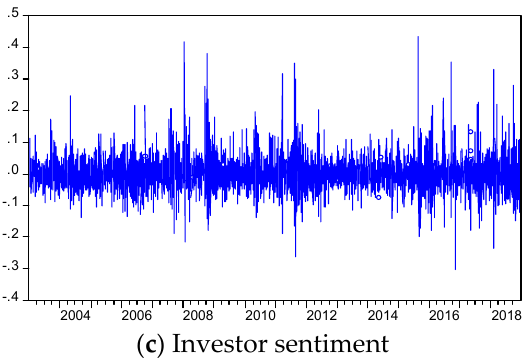
Figure 1. Dynamics of Cross-Sectional Absolute Deviation (CSAD) and Sent series: ( a ) CSAD for the KOSPI market; ( b ) CSAD for the KOSDAQ market; ( c ) Investor sentiment. Table 1. Descriptive statistics and unit root test of CSAD and Sent.